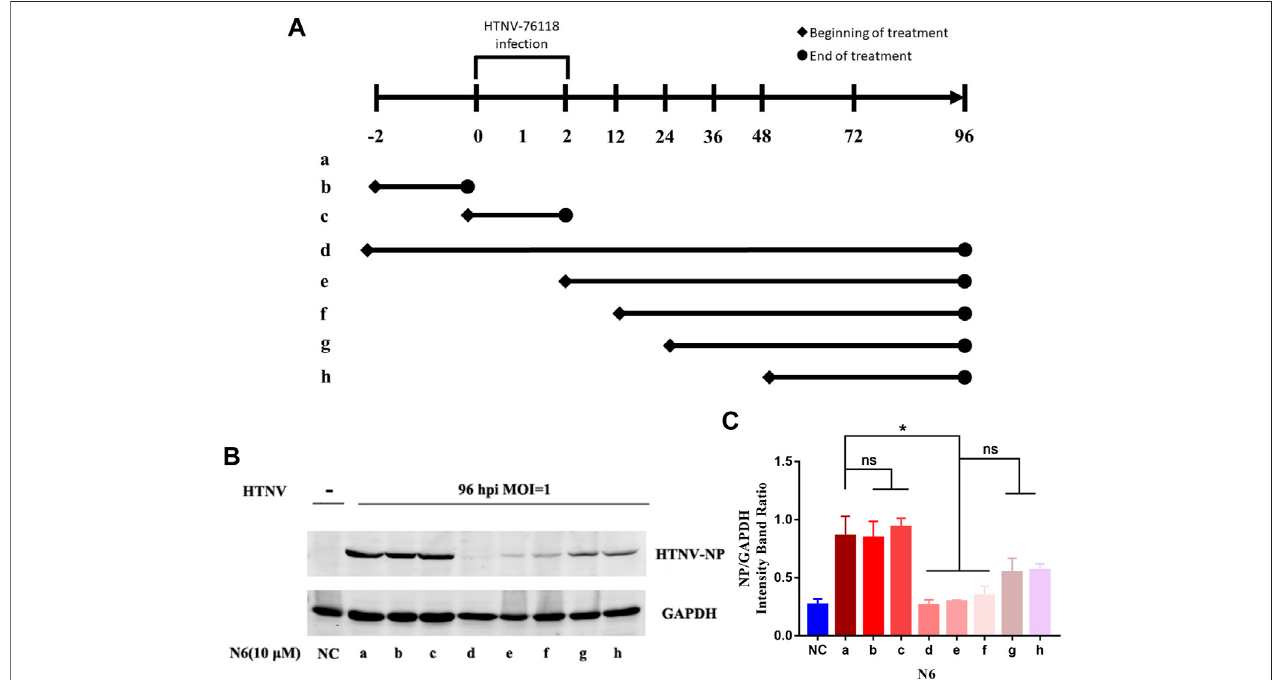
FIGURE 4 | N6 reduced the expression of HTNV-NP at the early stage of HTNV infection (A) Different administration regimens of 10 μ M N6 treated to the HTNV- infected A549 cells at an MOI of 1.0. Lane a: without N6 treatment; lane b: N6 treatment for 2 h pre-infection; lane c: N6 treatment for 2 h post infection; lane d – h: treatment continues from 2 h pre-infection, 2, 12, 24, and 48 hpi to the 96 hpi time point (B) The representative Western blot staining for HTNV NP protein in the groups withdifferentadministrationregimensofN6 (C) TheanalyzedresultoftheexpressionofHTNV-NPingroupswithdifferentadministrationregimensofN6.Resultsof the statistical analyses are depicted as follows: Student ’ s t test or one-way ANOVA; ns, p > 0.05, * p < 0.05 vs HTNV, n (cid:2) 3.